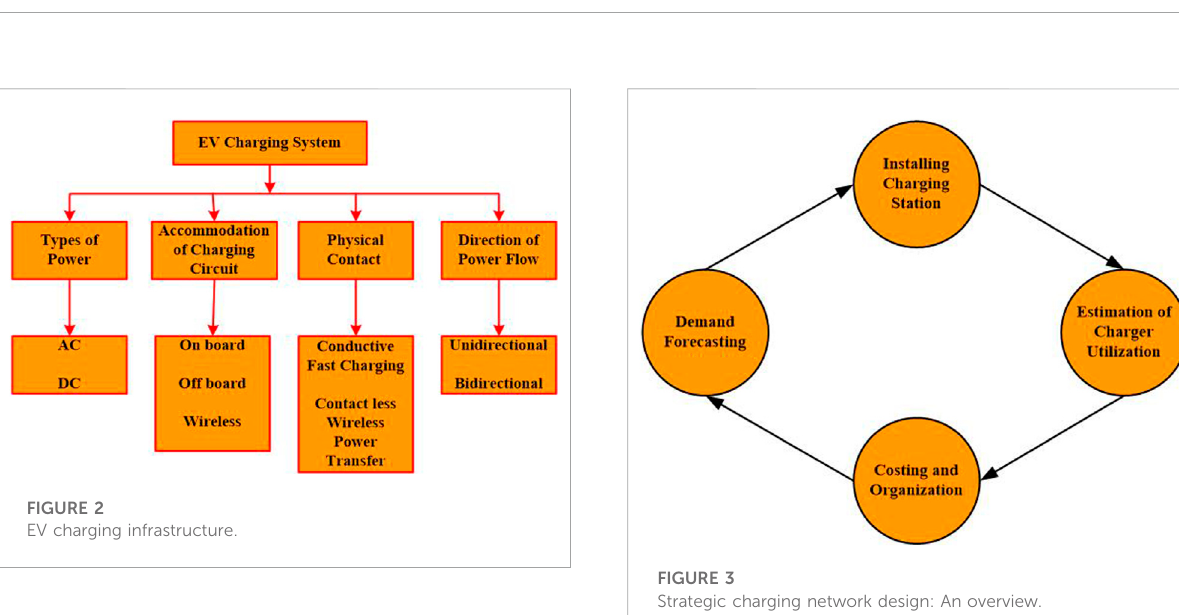
FIGURE 1 Approaches to the conceptualization of the problem regarding the optimal location of EVCS.